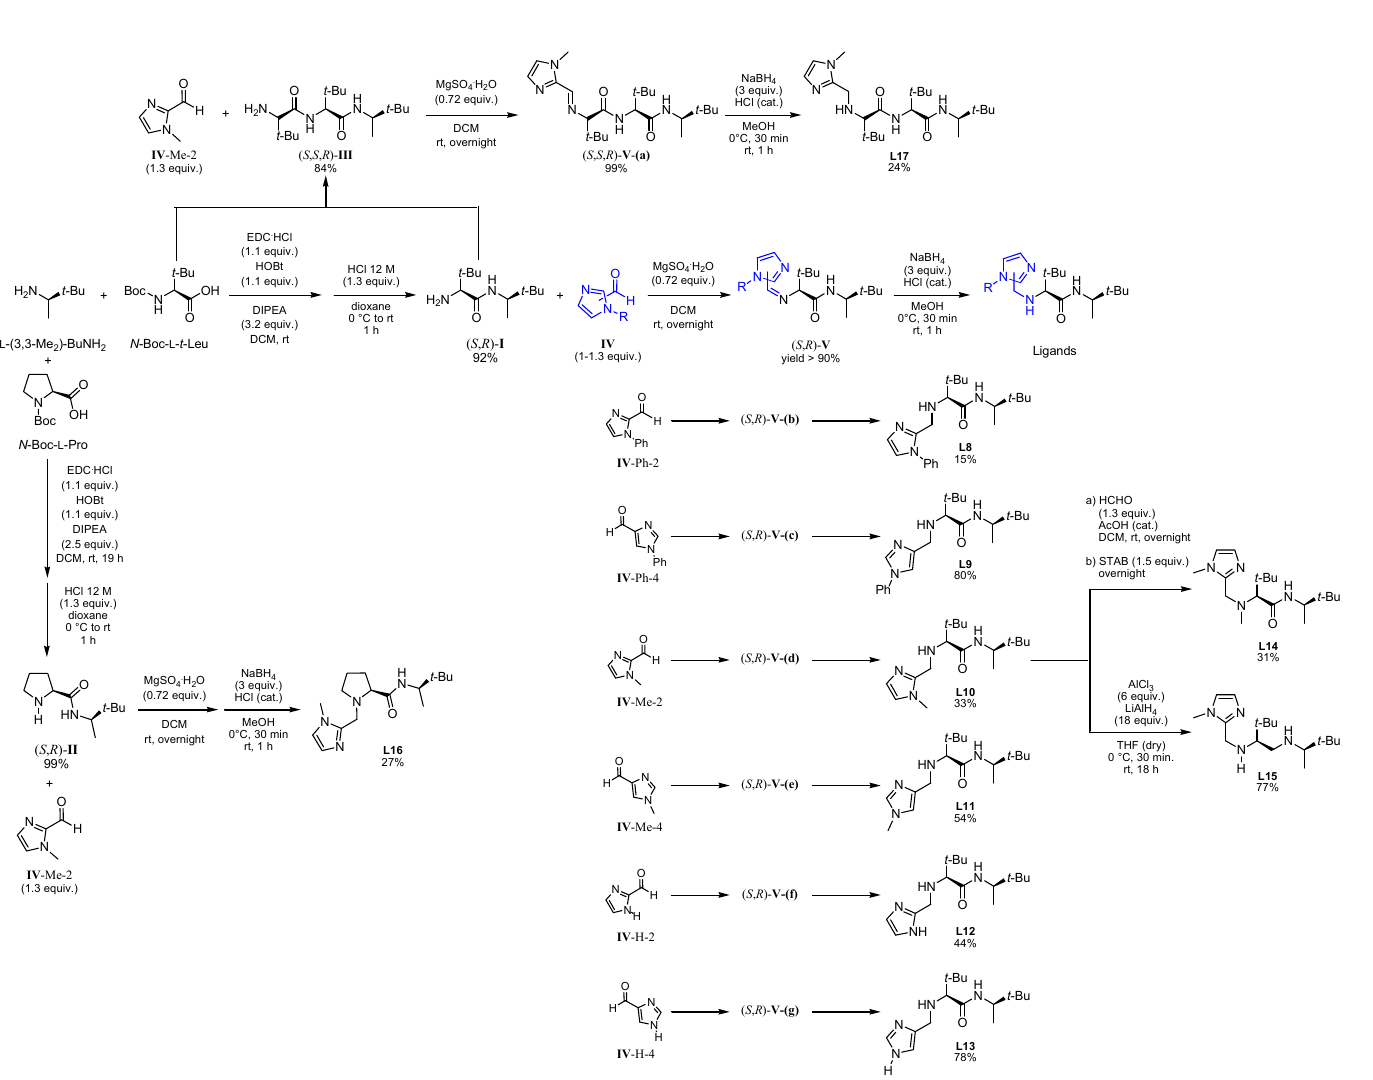
Figure 4. Family tree of chiral derivatives synthesized from ( R )-3,3-dimethylbutan-2-amine.